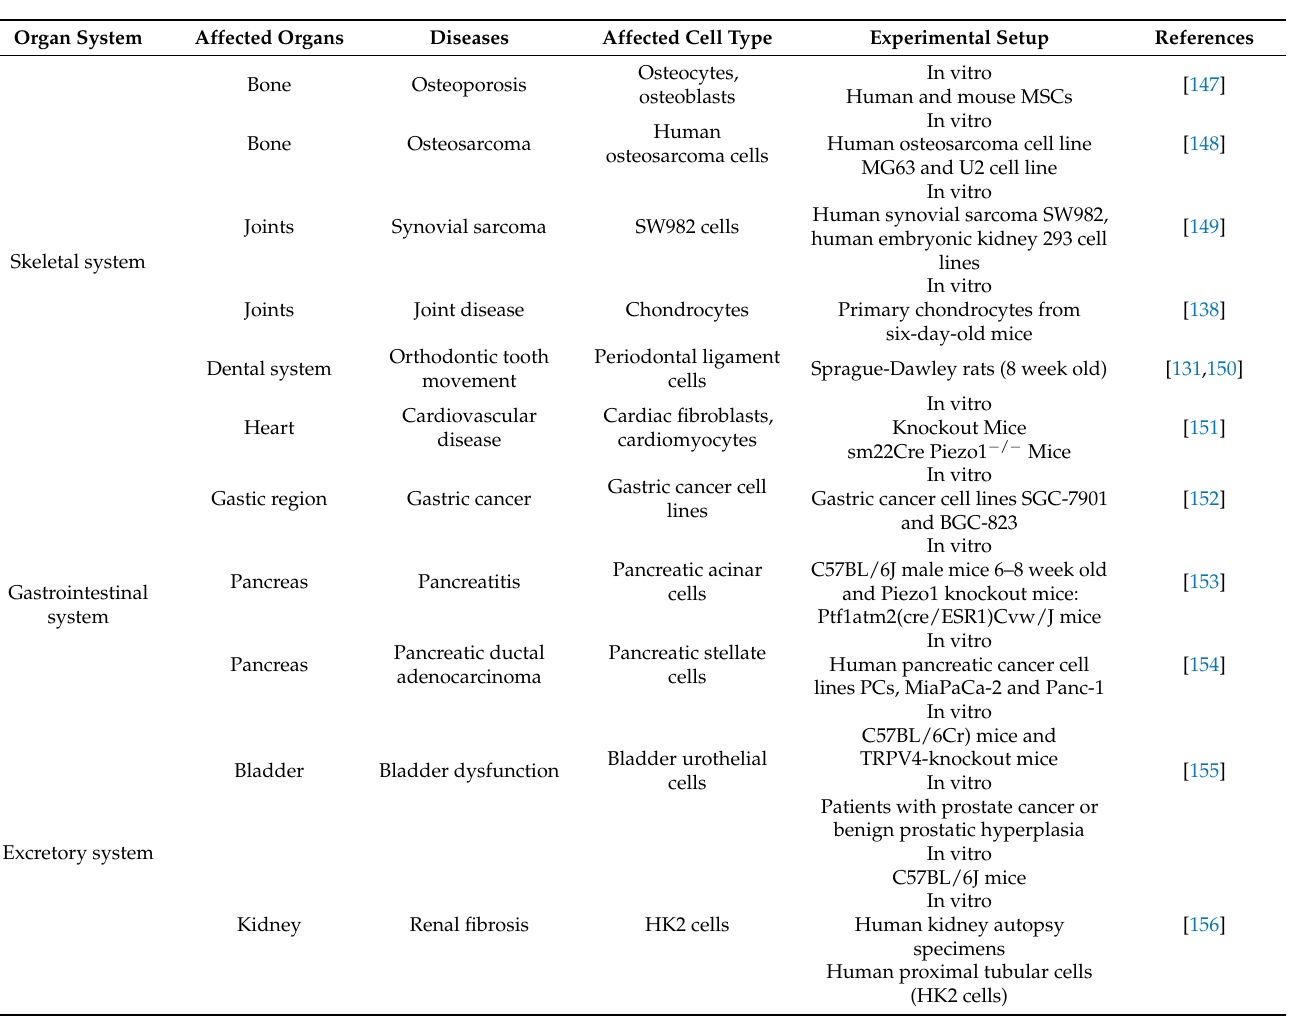
Table 2. Piezo1 channel associated